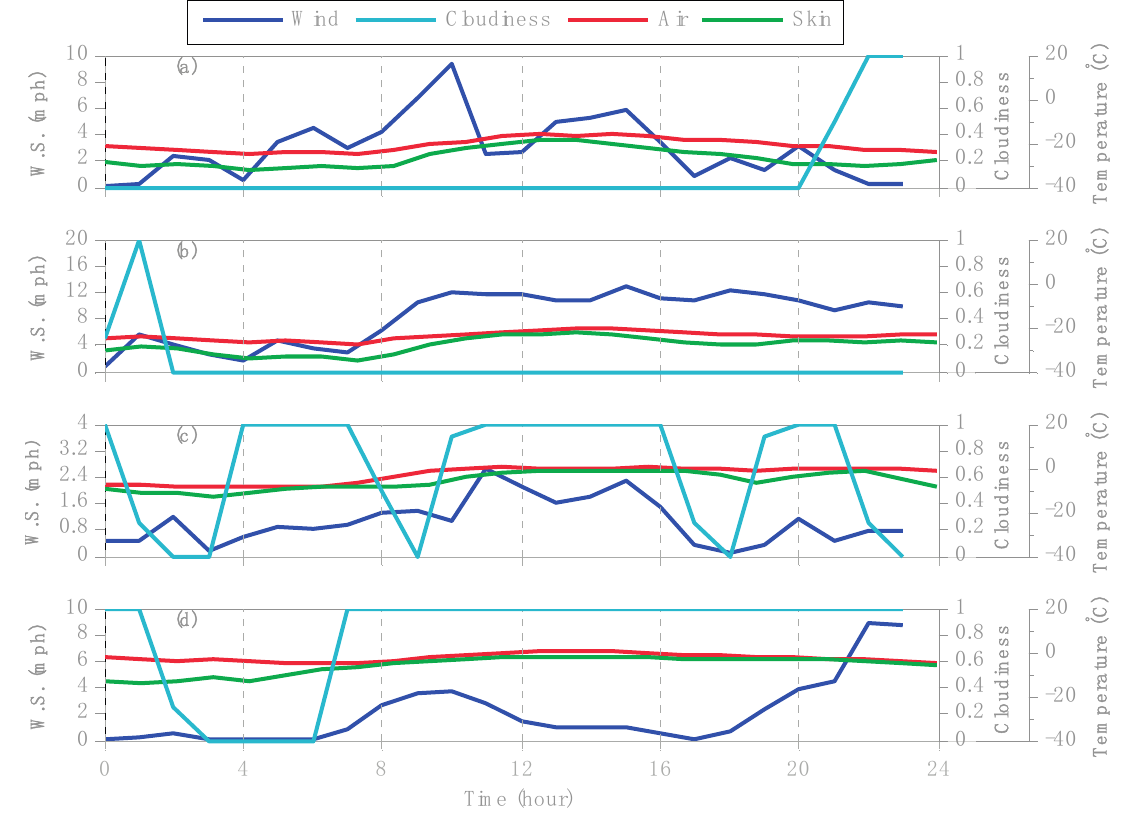
Figure 10. Snow surface and near-surface air temperature hourly values at the CREST-SAFE station in Caribou, ME for the days of 22–23 January ( a , b ) and 15–16 February ( c , d ) of winter